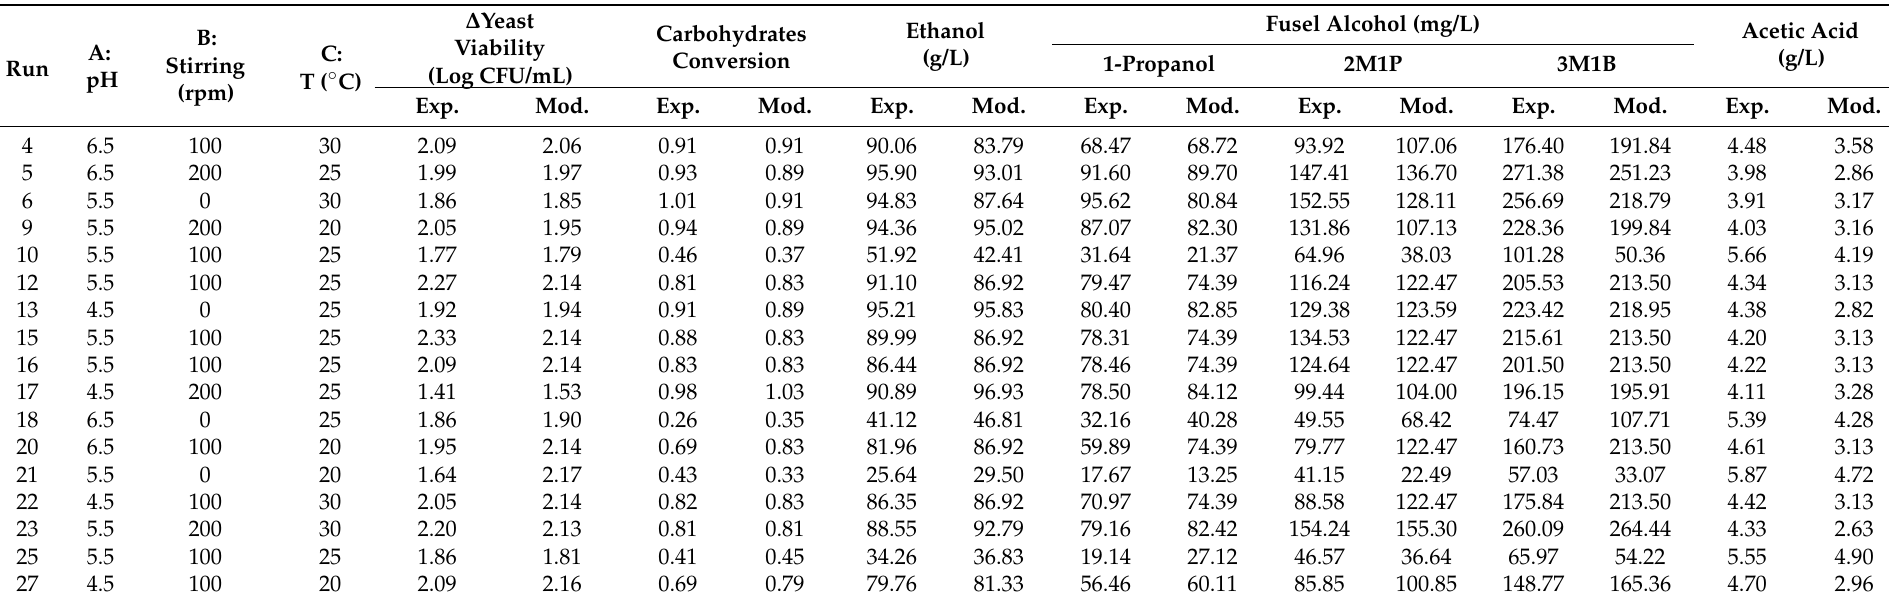
Table 3. Experimental design for the effect of fermentation factors such as pH (A), stirring (B), and temperature (C) over the final change in yeast viability (Log CFU/mL), carbohydrates conversion, ethanol (g/L), 1-propanol (mg/L), 2-methyl-1-propanol (mg/L), 3-methyl-1-butanol (mg/L), and acetic acid (g/L) concentration after 24 h fermentation of